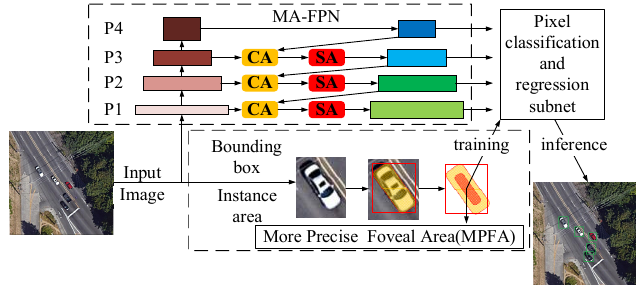
Figure 5. Schematic diagram of the overall network.